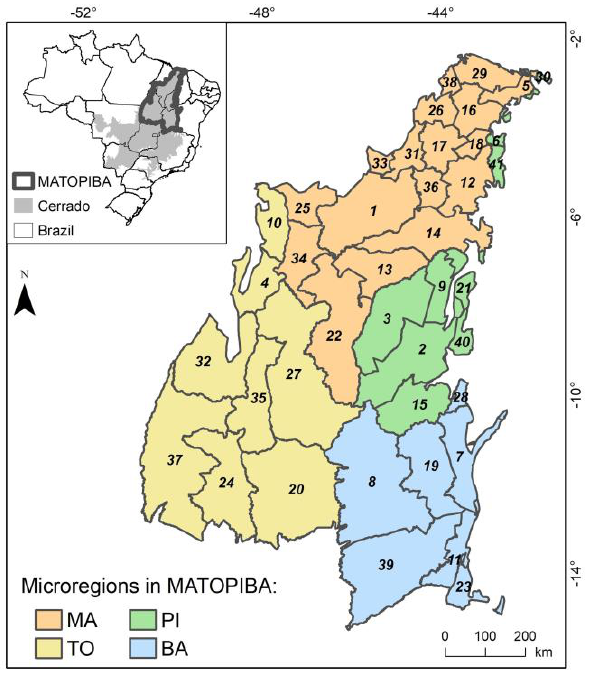
Figure 1. Spatial distribution of the 41 microregions from MATOPIBA in the Cerrado